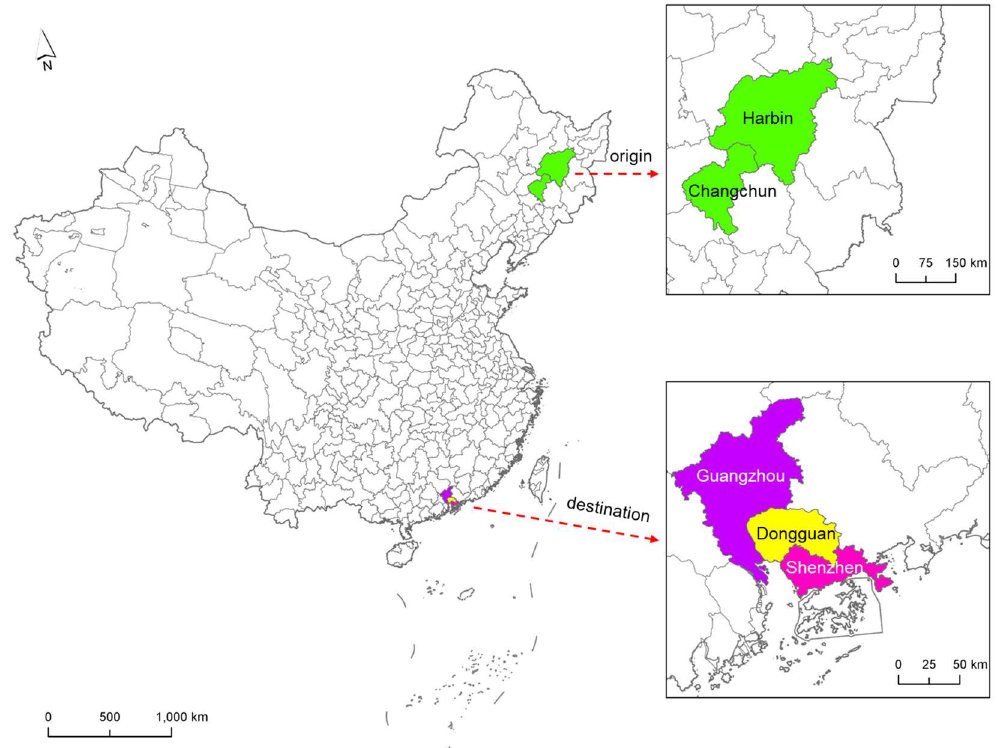
Figure 5. Flow cluster from Northeast China to the Pearl River Delta.